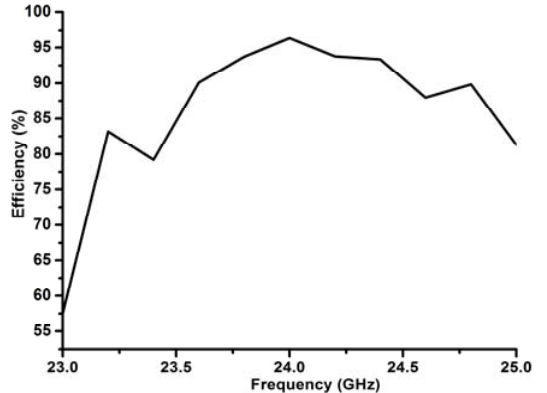
Figure 11: CST Simulated radiation efficiency of the proposed NDRA